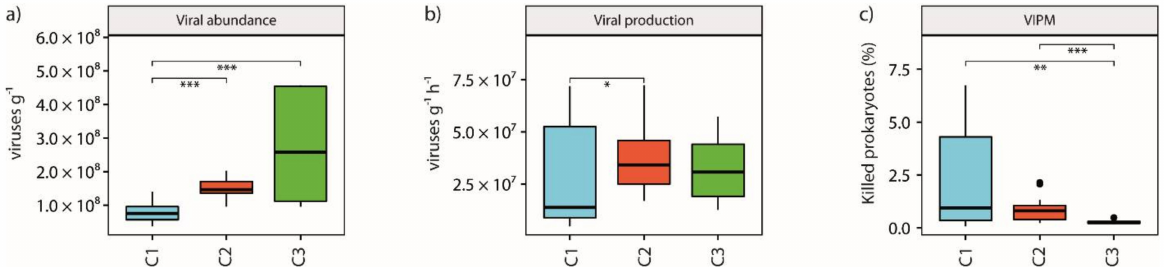
Figure 3. Impact of acidification on viral abundance and dynamics. Histograms showing the average values for viral abundances ( a ), viral production ( b ) and viral-induced prokaryotic mortality (VIPM; c ) among the 3 clusters identified, with asterisks displaying significant differences between clusters (* for p -values < 0.05, ** for p -values < 0.01, *** for p -values < 0.001) and error bars computed on the standard error for each